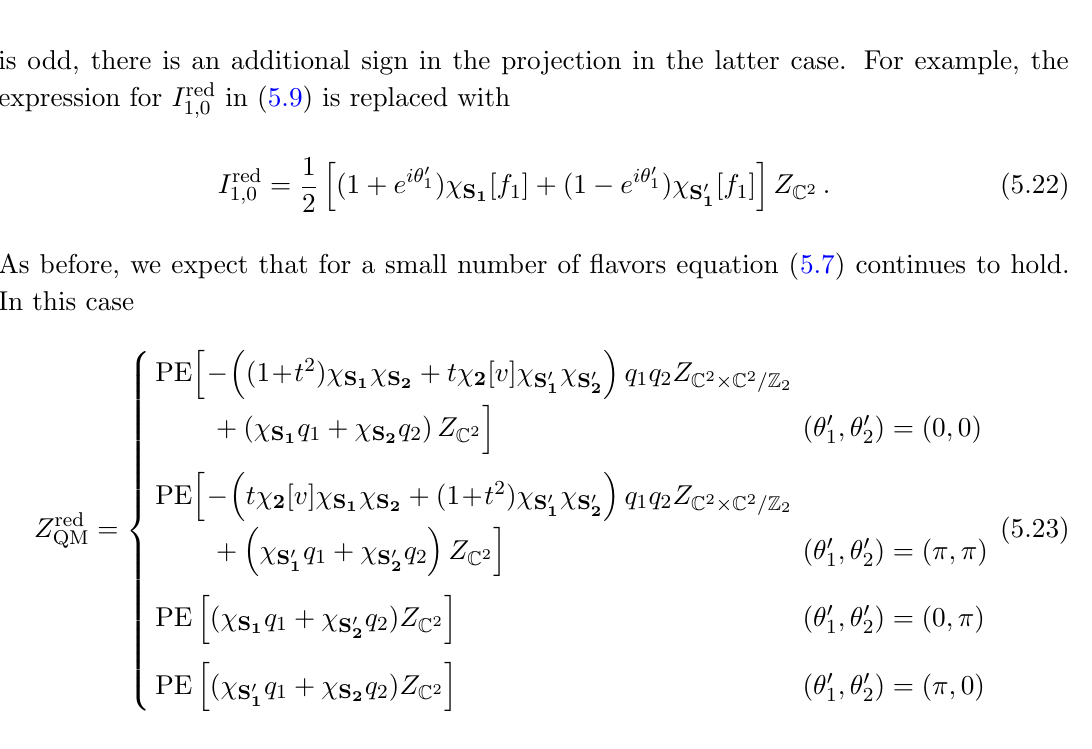
Figure 6 . 1d N = (0 ; 4) theory for the 5d Sp( N and fundamental